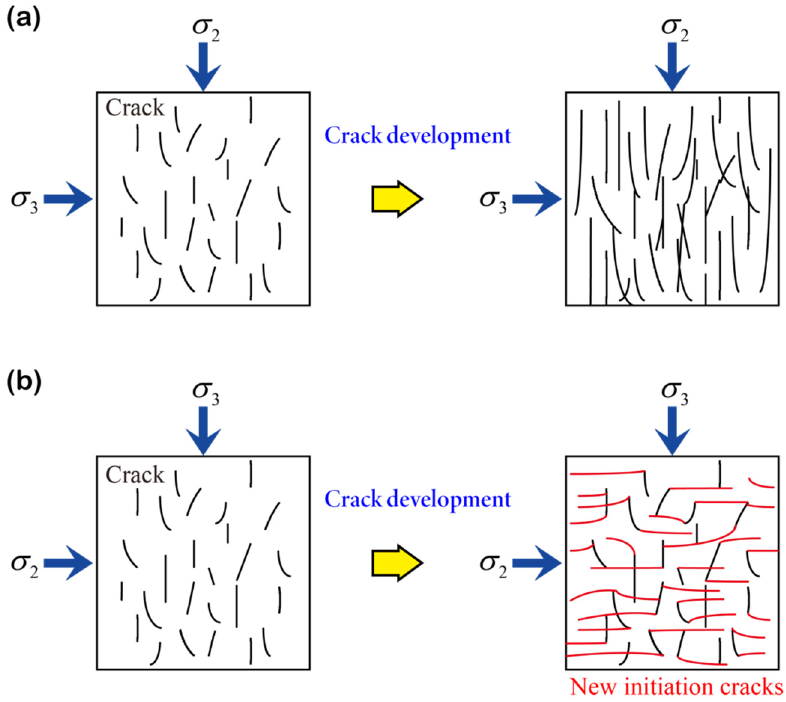
Figure 12. The effect of intermediate principal stress on the propagation law of internal fractures in rock: ( a ) the initial direction of internal cracks is parallel to σ 2 ; ( b ) the initial direction of internal cracks is perpendicular to σ 2 .